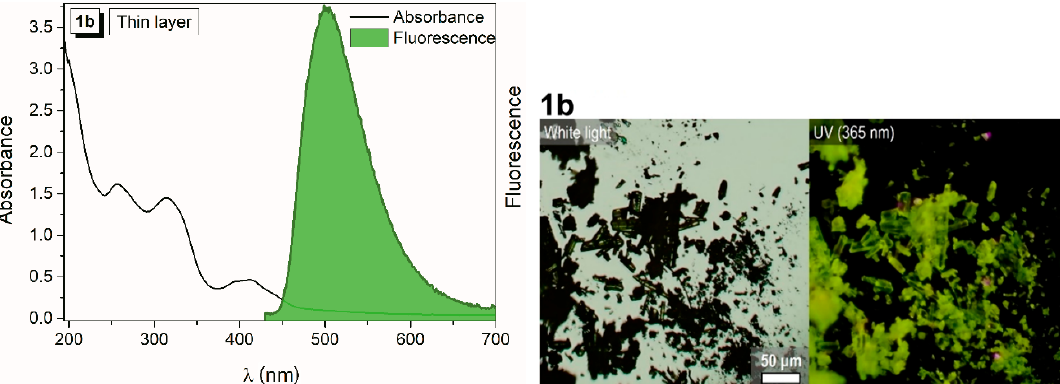
Figure 2. Absorption and emission spectrum of 1b in the thin solid film layer on the quartz substrate ( λ EXC = λ A ) ( left ) and micrograph of synthesized azafluorenone 1b under visible (white) light and UV light (365 nm). The micrograph illustrates the crystals and fluorescence of 1b in thin solid film ( right ).